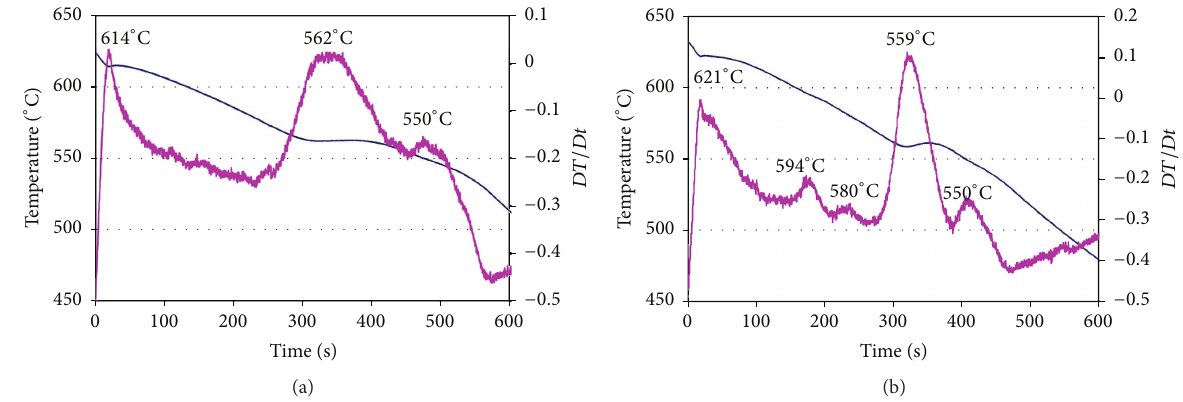
Figure 3: Solidification curve and the first derivative for (a) T0 alloy and (b) T9 alloy.